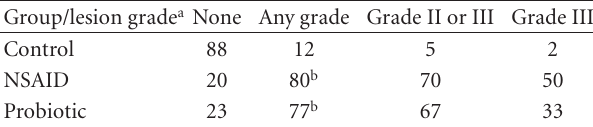
Table 2: Prevalence of gastric